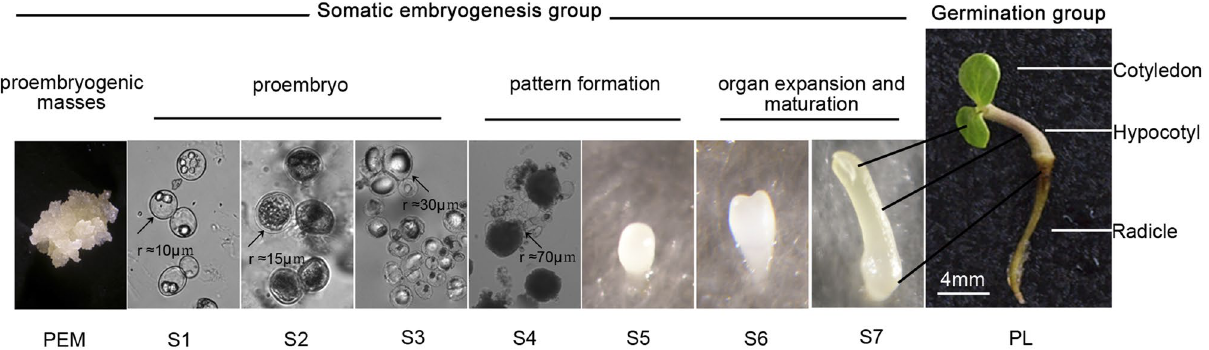
Figure 1. Somatic embryogenesis and germination groups of Liriodendron hybrids. The somatic embryogenesis group includes PEM and S1–S7, while the germination group includes cotyledon, hypocotyl and radicle. PEM, proembryogenic masses; S1, proembryogenic single cell stage; S2,embryogenic single cell stage; S3, two to four cell proembryo stage; S4, multicell proembryo stage; S5, globular embryo stage; S6, heart/torpedo -shaped embryo stage; S7, cotyledon embryo stage; PL, plantlet developed from somatic embryo. (The images of PEM and S1 to S7 were provided by the Key Laboratory of Forest Genetics and Biotechnology, Ministry of Education of China, Co-Innovation Center for the Sustainable Forestry in Southern China, Nanjing Forestry